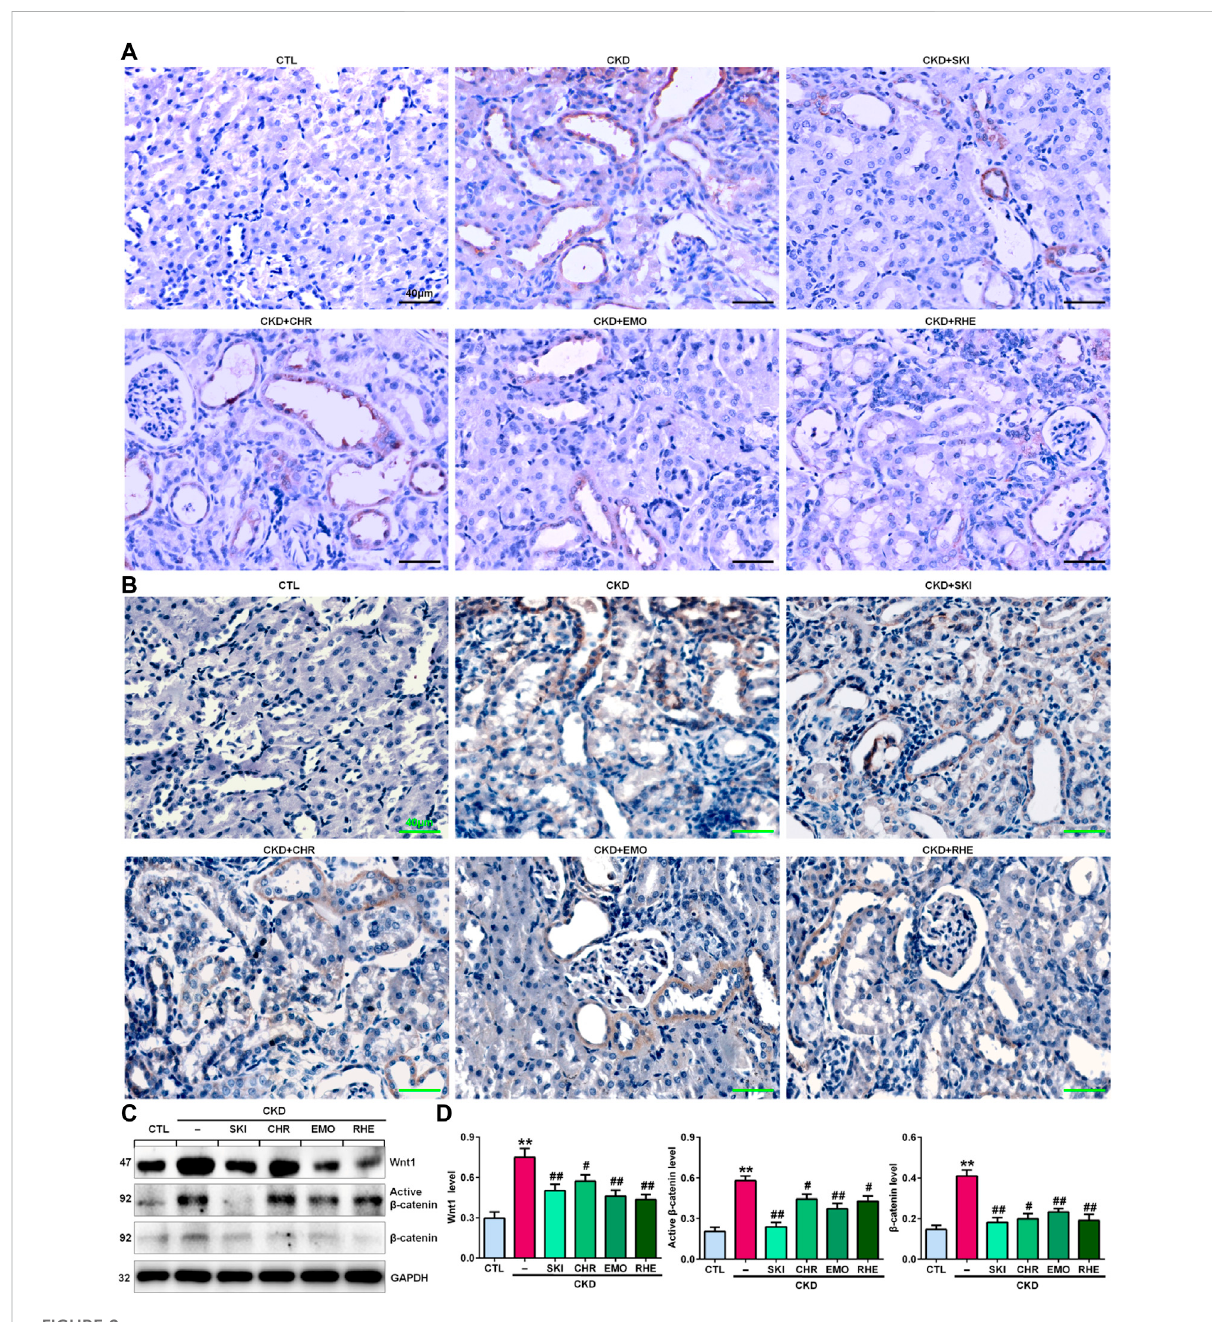
FIGURE 2 SKI suppressed Wnt1/ β -catenin signalling in CKD rats. (A) Immunohistochemical analysis of intrarenal Wnt1 expression in the different groups. (B) Immunohistochemicalanalysisofintrarenal β -cateninexpressioninthedifferentgroups. (C) ProteinexpressionlevelsofintrarenalWnt1,active β - catenin and β -catenin in thedifferentgroups. (D) Quantitative analysis ofthe protein expression ofintrarenalWnt1, active β -catenin and β -catenin in the different groups. Scale bar, 40 μ m ** p < 0.01 compared with CTL rats; # p < 0.05, ## p < 0.01 compared with CKD rats. Abbreviations: CHR, chrysophanol; EMO, emodin; RHE,